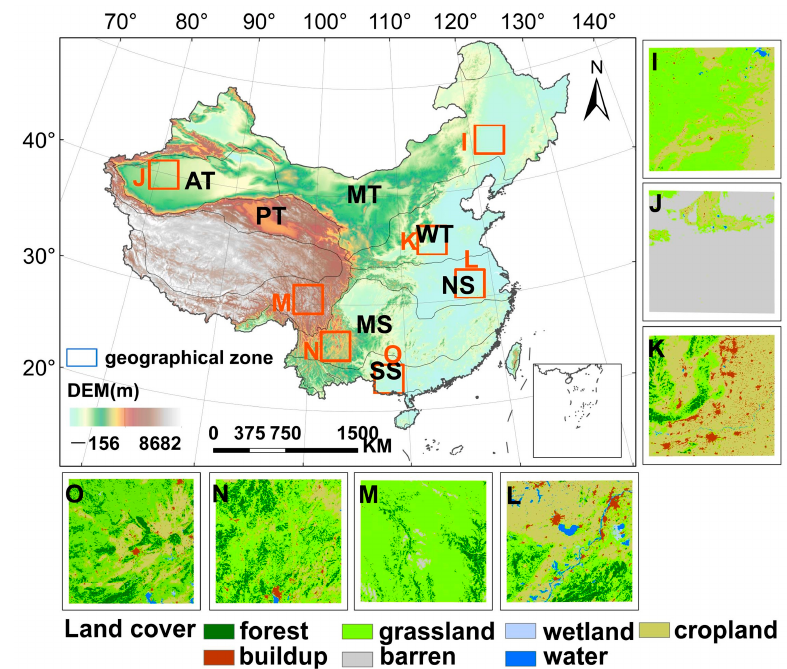
Figure A3. Study areas. The red boxes refer to the selected Regions I–O, which are located in mid-temperate (MT), arid temperate (AT), warm temperate (WT), northern subtropical (NS), plateau temperate (PT), mid-subtropical (MS), and southern subtropical (SS) climates, respectively. Subfigures ( I – O ) represent the land cover types of the corresponding study areas.